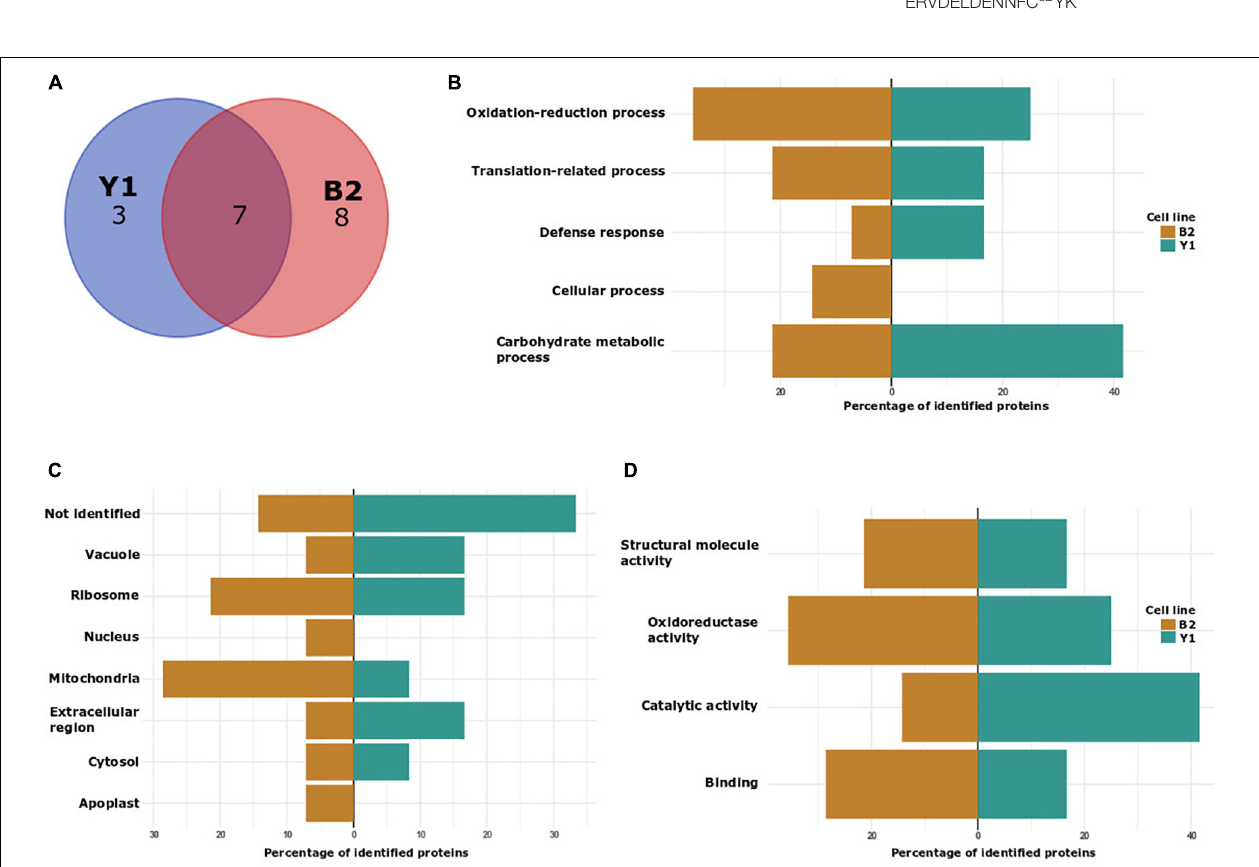
FIGURE 4 | Characterization of in vivo S-nitrosated proteins detected during cultivation of cell lines Y1 and B2 of Brazilian pine in medium culture supplemented with maturation promoters (osmotic agents and ABA). (A) VENN diagram depicting the number of identified proteins in cell lines Y1 and B2 after 4 months of maturation. (B) Biological process classification in GO analysis of proteins detected in cell lines Y1 and B2 after 4 months of maturation. (C) Cellular component and (D) molecular function.